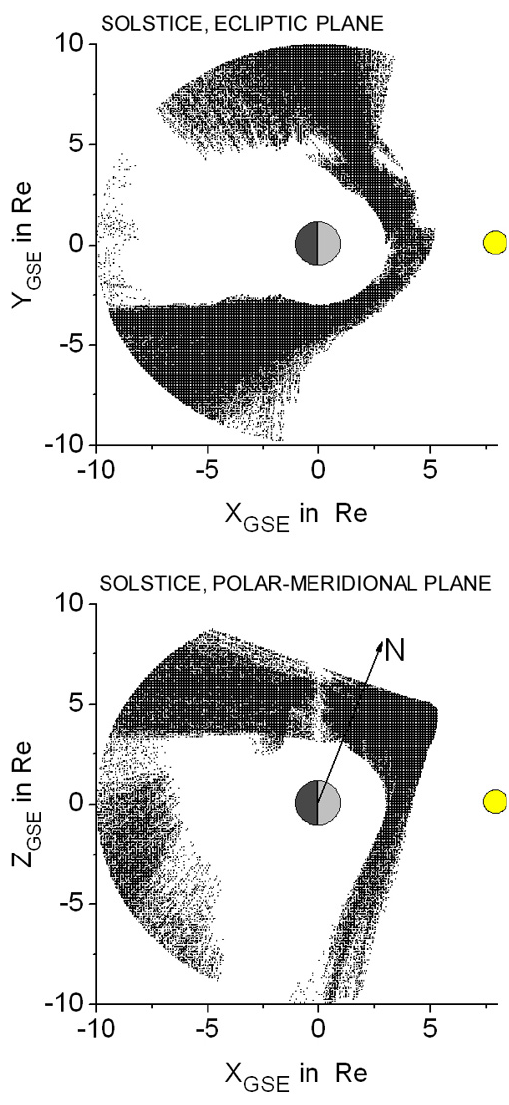
Fig. 2. Observational LOS-coverage: Lines of sight intersections with (top) the ecliptic plane (within an angular extent of θ ± 25 ◦ around the ecliptic plane) and (bottom) the polar–meridonal plane (within an angular extent of φ ± 25 ◦ around the polar–meridional plane) for the summer-solstice